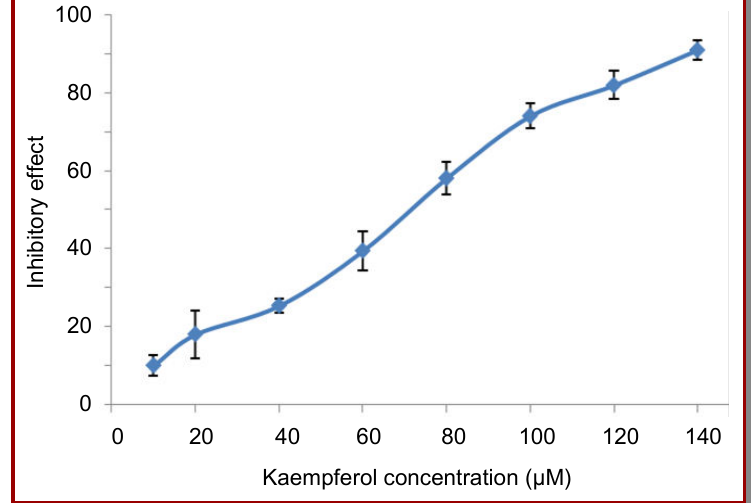
Kaempferol concentration Figure 1 : Inhibitory effects of kaempferol on the proliferation of non-small cell lung cancer cells. A549 cells were treated with in- creasing concentrations of kaempferol for 24 hours